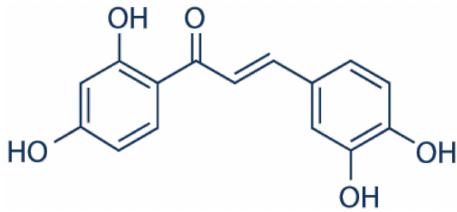
Figure 14. The chemical structure of